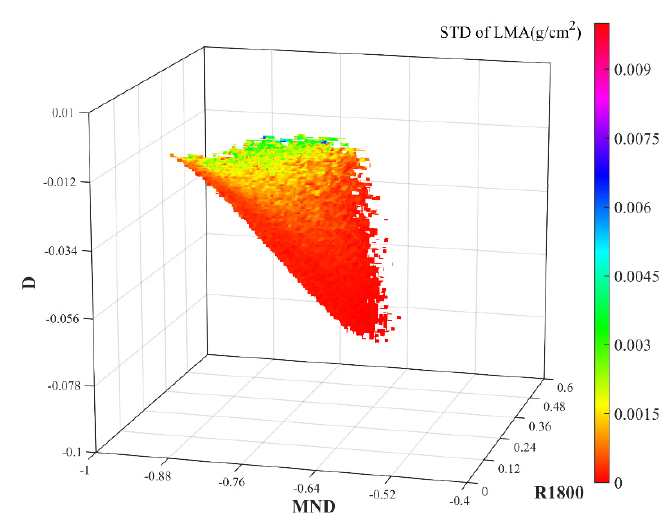
Figure 5. The standard deviation 3D matrix of R1800-MND-D.